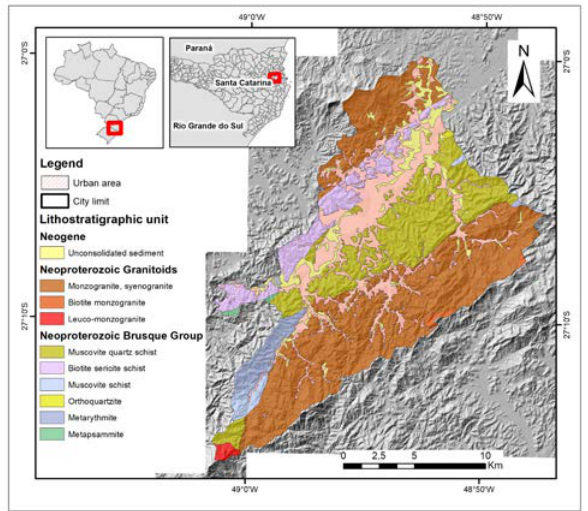
Figure 1. Schematic geologic map superimposed on a Digital Elevation Model of the Brusque City, Santa Catarina State, Brazil (Modified after Basei et al.,